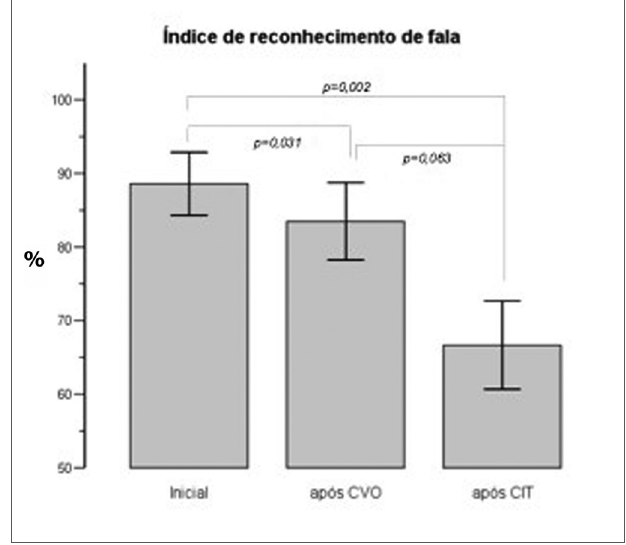
Figura 5. Comparação entre Recuperação do IRF após Corticoterapia Oral e